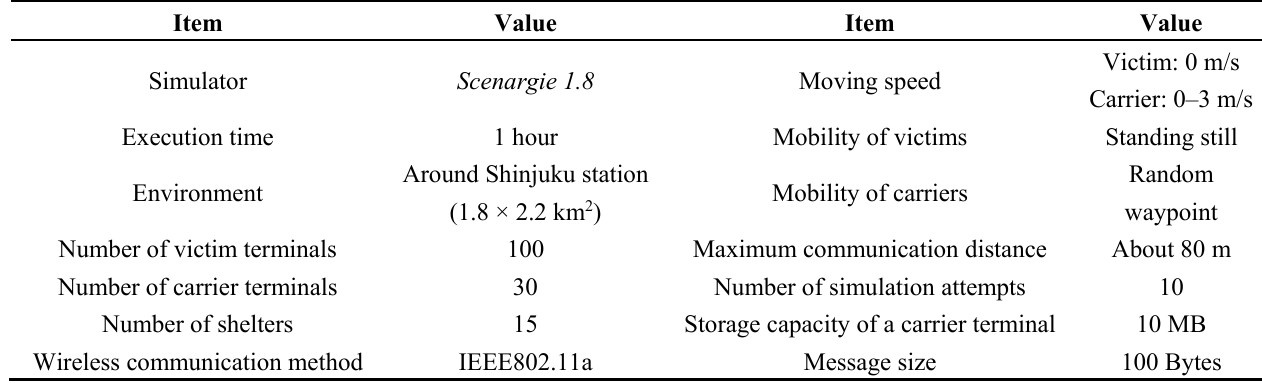
Table 3. Simulation